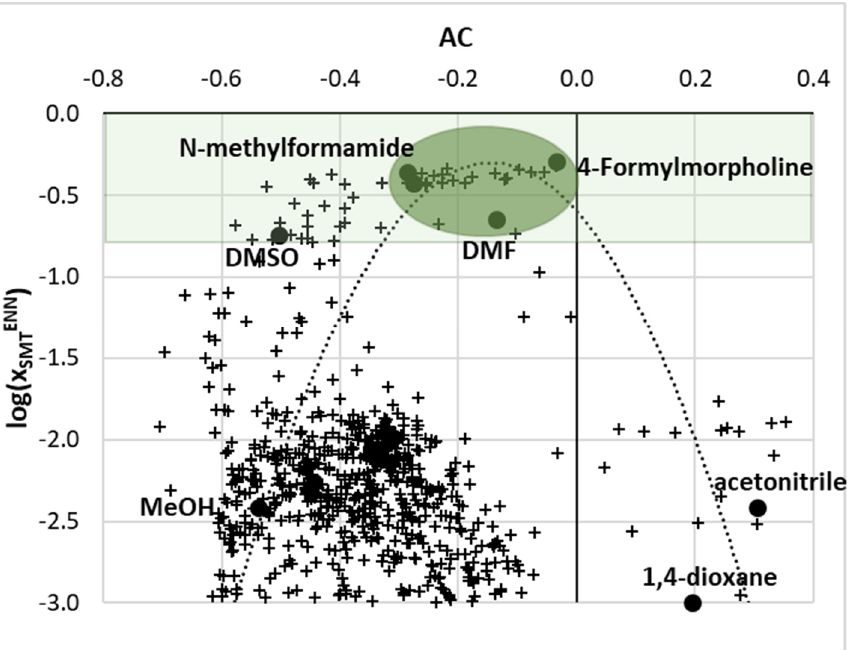
Figure 10. Correlation of the computed values of SMT solubility and values of the affinity comple- mentarity index.